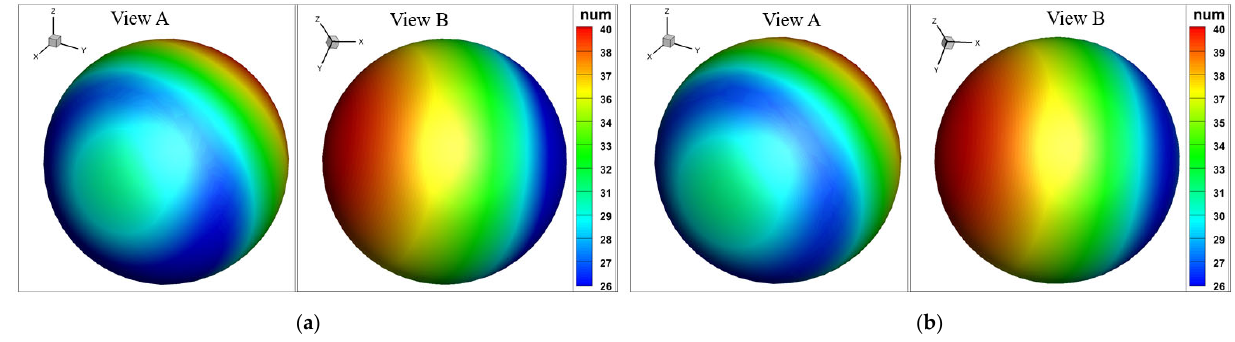
Figure 6. Distributions of the scattered sound pressure level on the investigated surface obtained by using the FEM and RSF-BM-SBM: ( a ) FEM; ( b ) RSF-BM-SBM.